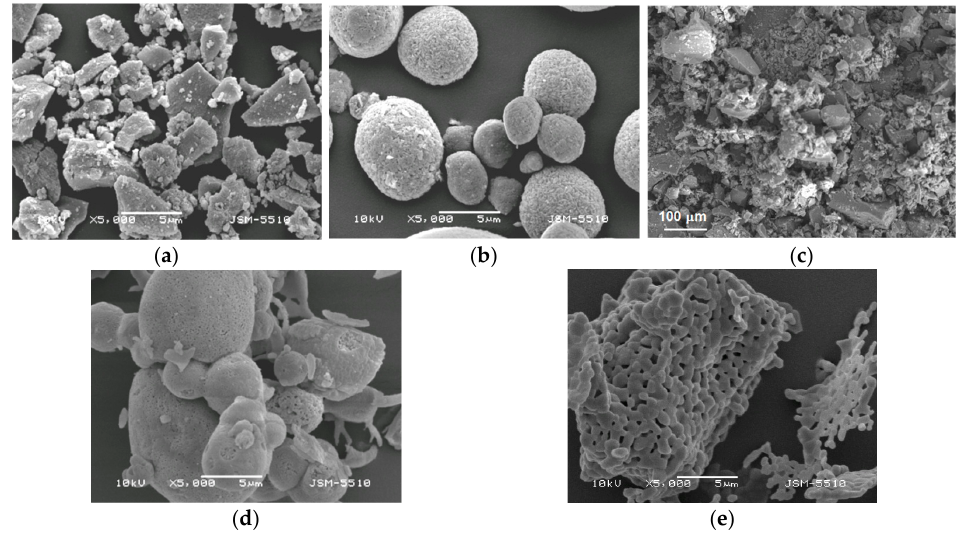
Figure 3. SEM images: ( a ) β -Ni 1/2 Mn 1/2 (OH) 2 ; ( b ) ilmenite NiMnO 3 ; ( c ) mixture of NiMnO 3 and Ni 1.5 Mn 1.5 O 4 ; ( d ) olivine LiNi 1/2 Mn 1/2 PO 4 ; and ( e ) maricite NaNi 1/2 Mn 1/2 PO 4 .